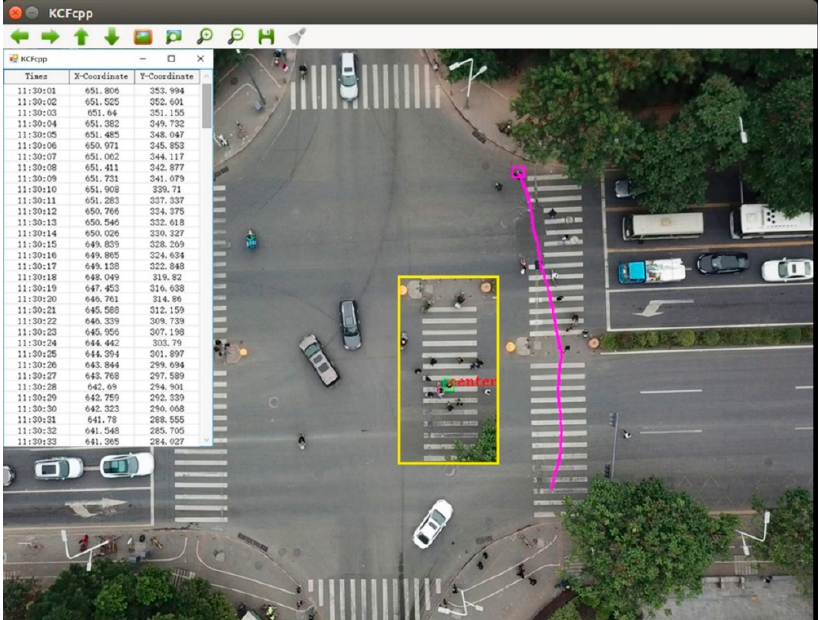
Figure 7. An example of a pedestrian trajectory. The image with the yellow boundary is the tracking result of one pedestrian in one frame. After processing one UAV video, the table at the upper left is obtained, showing the location set of the target.